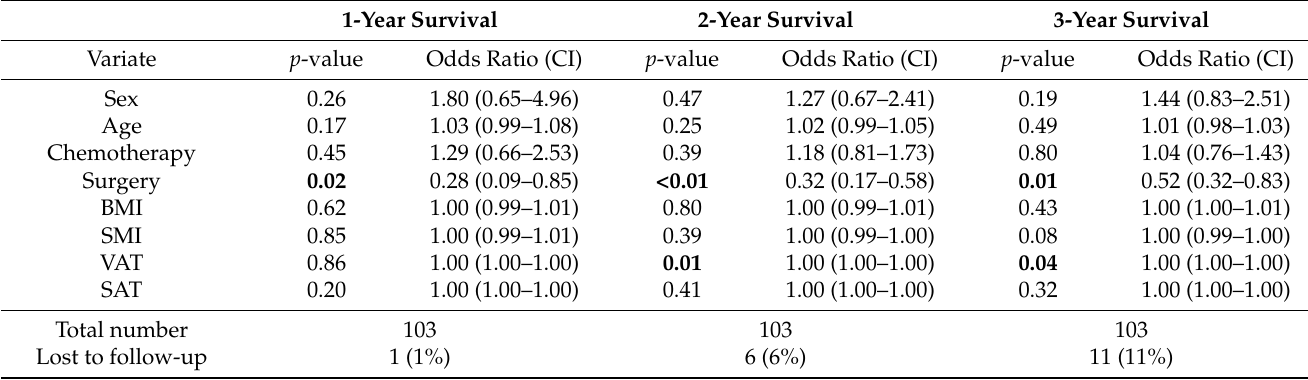
Table 4. Cox regression analysis of all patients with pancreatic adenocarcinoma. Surgery, sex, age, BMI, chemotherapy, and the AI-derived body composition parameters SMI, VAT, and SAT served as independent variates. 1-Year Survival 2-Year Survival 3-Year